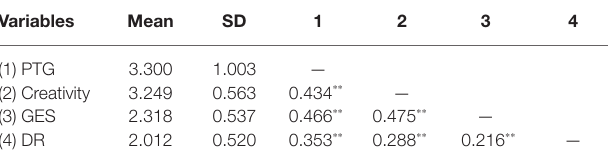
TABLE 1 | Descriptive statistics and correlations among variables.